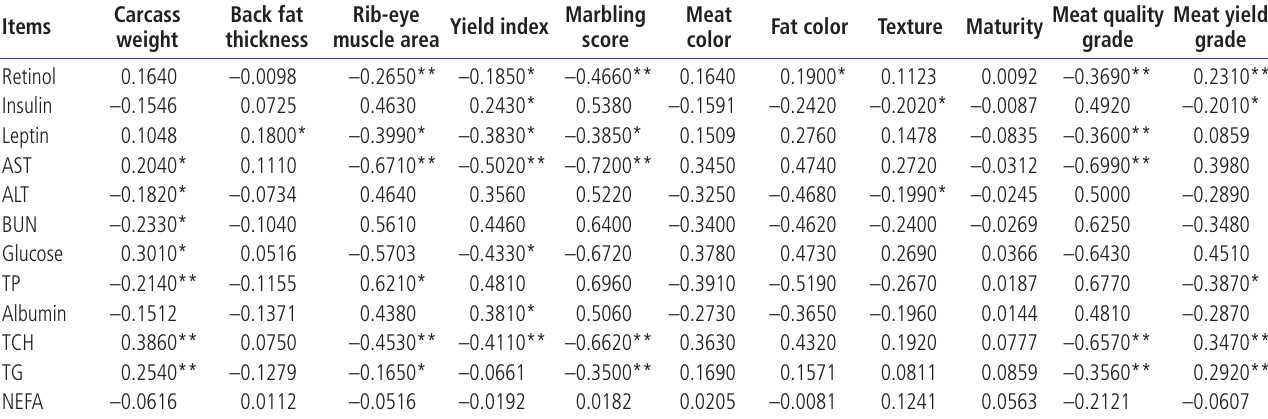
Table 4. The correlation coefficients between blood biochemical components during fattening and finishing phases and carcass traits in Hanwoo steers Carcass Back fat Rib-eye Marbling Meat Items Yield index Fat color Texture Maturity weight thickness muscle area score color